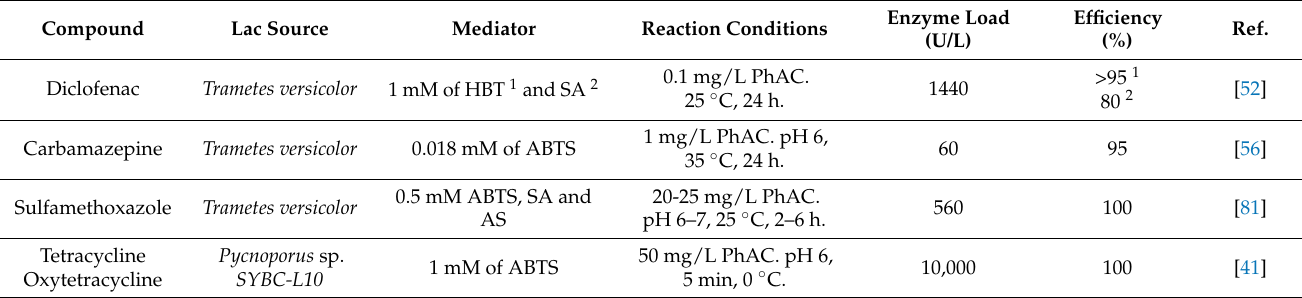
Table 3. Examples of biodegradation of pharmaceutical micropollutants by Lac coupled with reaction